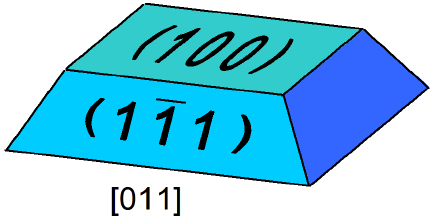
Figure 3. SAQD shape with the quadratic base along [011]-like directions and limited by (100) top/base planes and (111)-like side planes.